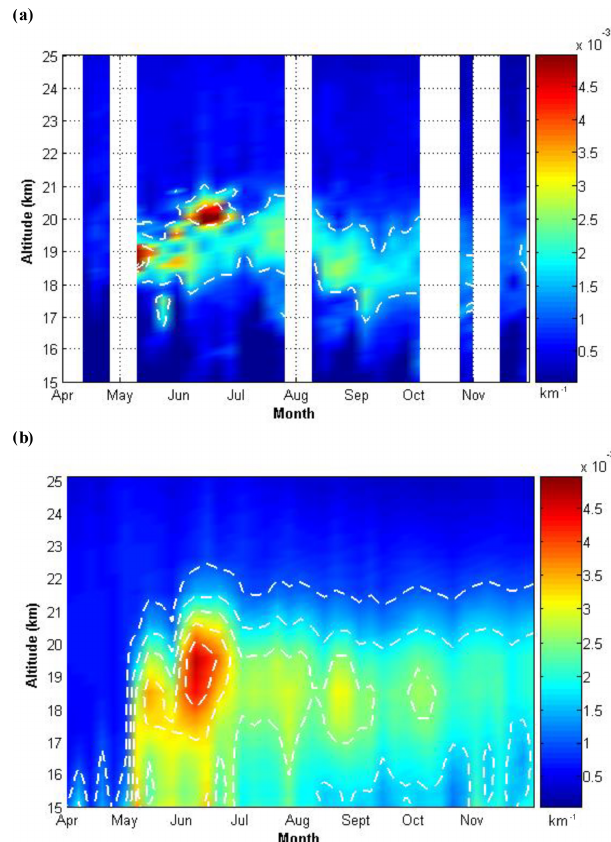
Figure 7. Time series of weekly averaged profiles of extinction at 532nm obtained from (a) ground-based lidar and (b) OMPS obser- vations over Reunion between April 2015 and December